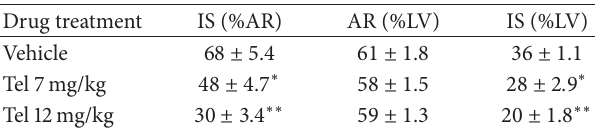
Table 1: Effects of telmisartan treatment on acute myocardial I/R injury in ZDF